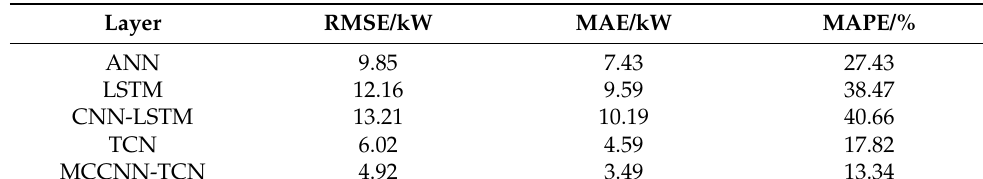
Table 12. Prediction results of different models.